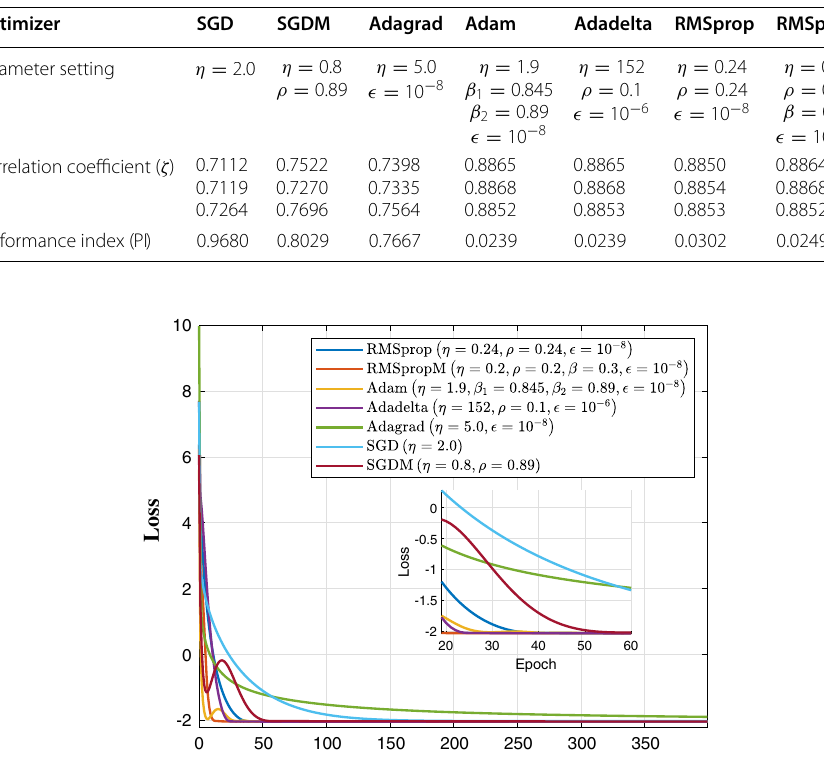
Table 3 The separation results of different optimizers in the form of ζ and PI with SNR Optimizer SGD SGDM Adagrad Adam Adadelta RMSprop RMSpropM Parameter setting